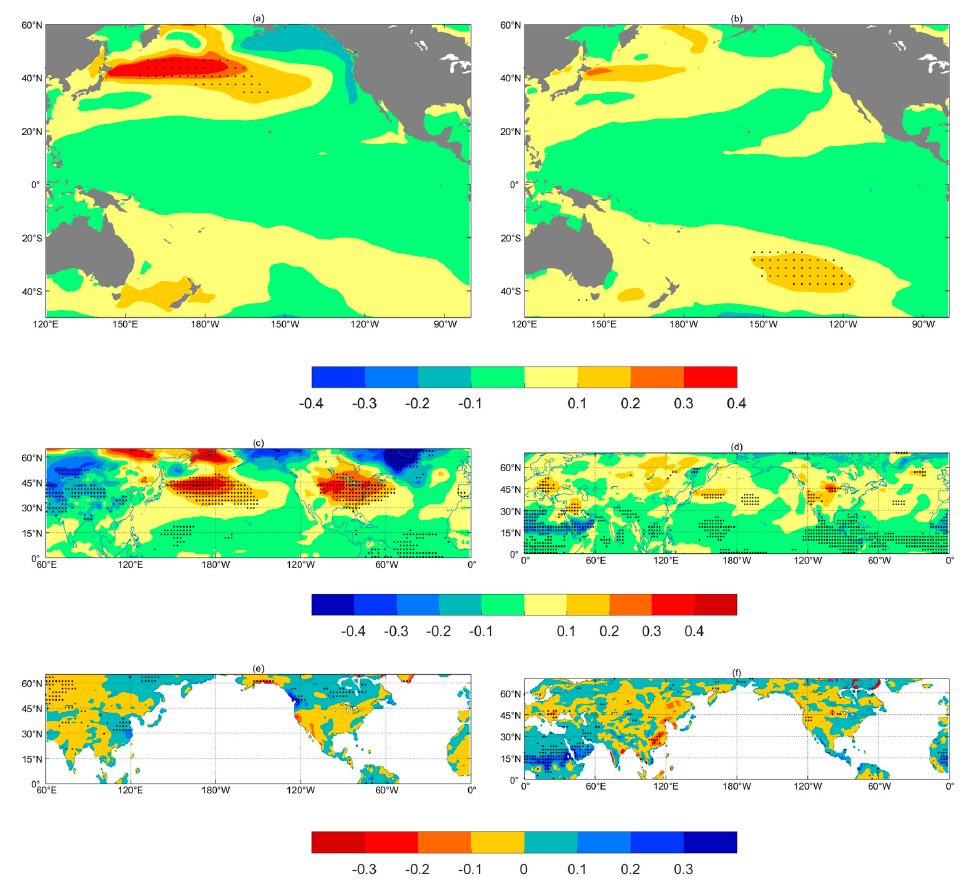
Figure 6. Regressions of SST anomaly (SSTA) onto ( a ) the NPIMV index and ( b ) the SPIMV index (unit: ◦ C per standard deviation). Regressions of the boreal winter ( c ) 2-meter air temperature ( ◦ C) and ( e ) rainfall (mm/day) onto the NPIMV index. Regressions of the austral winter ( d ) 2-meter air temperature ( ◦ C) and ( f ) rainfall (mm/day) onto the SPIMV index. Values exceeding 90% for the significance test are dotted. Data are obtained from the CMIP5 pre-industrial control simulation in the EC-ERATH model.